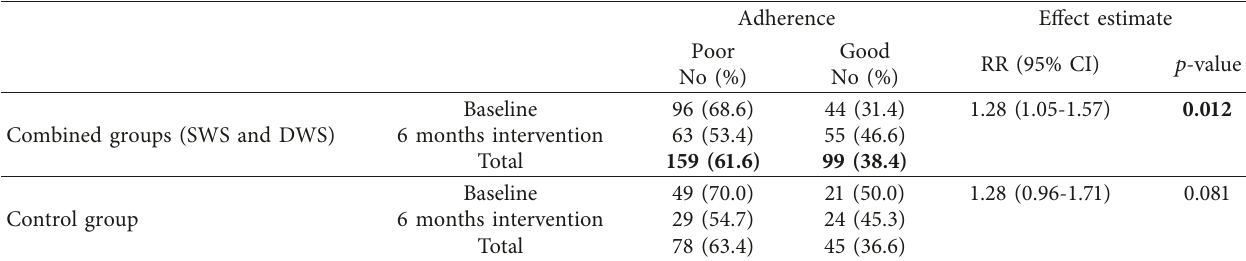
Table 9: Combined single-way and double-way adherence to ART before and after 6 months of intervention.